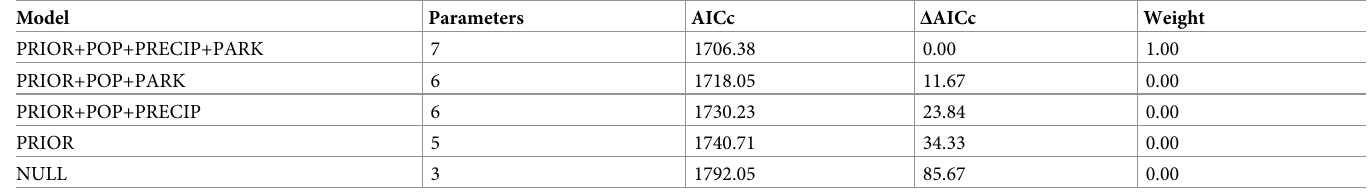
Table 1. Results of model selection for negative binomial regression models of high or moderate severity (Class 1–2) bear conflicts, New York, USA, July–September 2006–2019. We considered five candidate models: (a) no covariates (NULL), (b) mild severity (Class 3) conflicts early in the year (April–June) and bear abundance index (PRIOR+POP), (c) mild severity conflicts, abundance, and precipitation difference from means (PRIOR+POP+PRECIP), (d) mild severity conflicts, abundance, and parks (PRIOR+POP+PARK), and (e) a global model (PRIOR+POP+PRECIP+PARK). Models were ranked using Akaike Information Criterion for small samples (AICc). Model